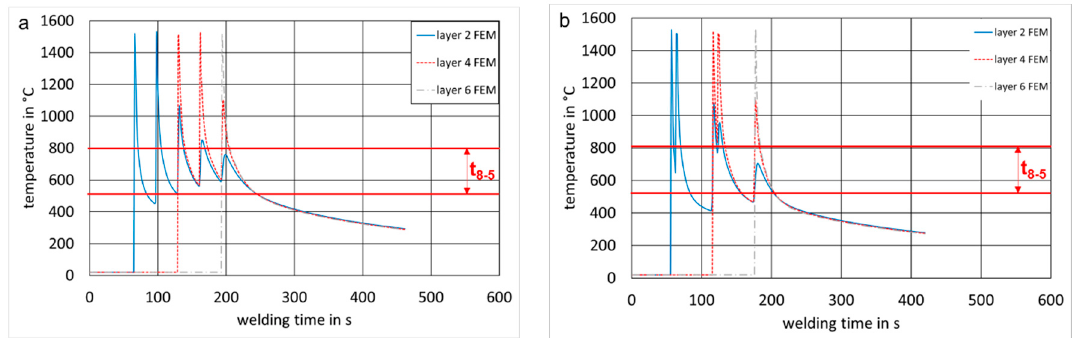
Materials 2018 , 11 , x FOR PEER REVIEW 7 of 10 Figure 7. Comparison of measured (solid line) and simulated (dotted line) temperatures of the discontinuous welding process for G4Si1 with v wire = 5.0 m/min and v welding = 40 cm/min.